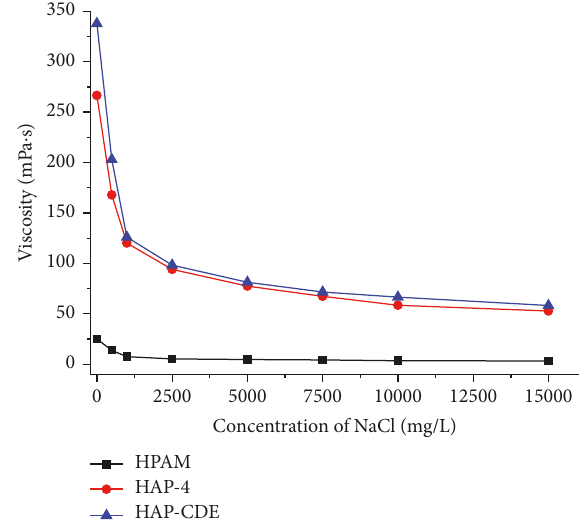
Figure 5: The effect of NaCl concentration on viscosity of polymer solutions (0.2 wt%, ̇𝛾 = 7.34s −1 ).